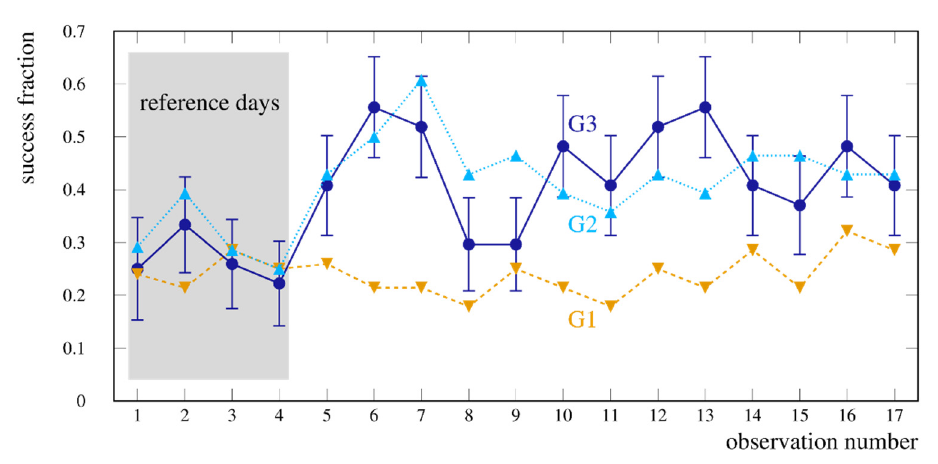
Figure 7. The time evolution of the success fraction for all three groups separately: the control group G1, the test group G2, and the test group G3.